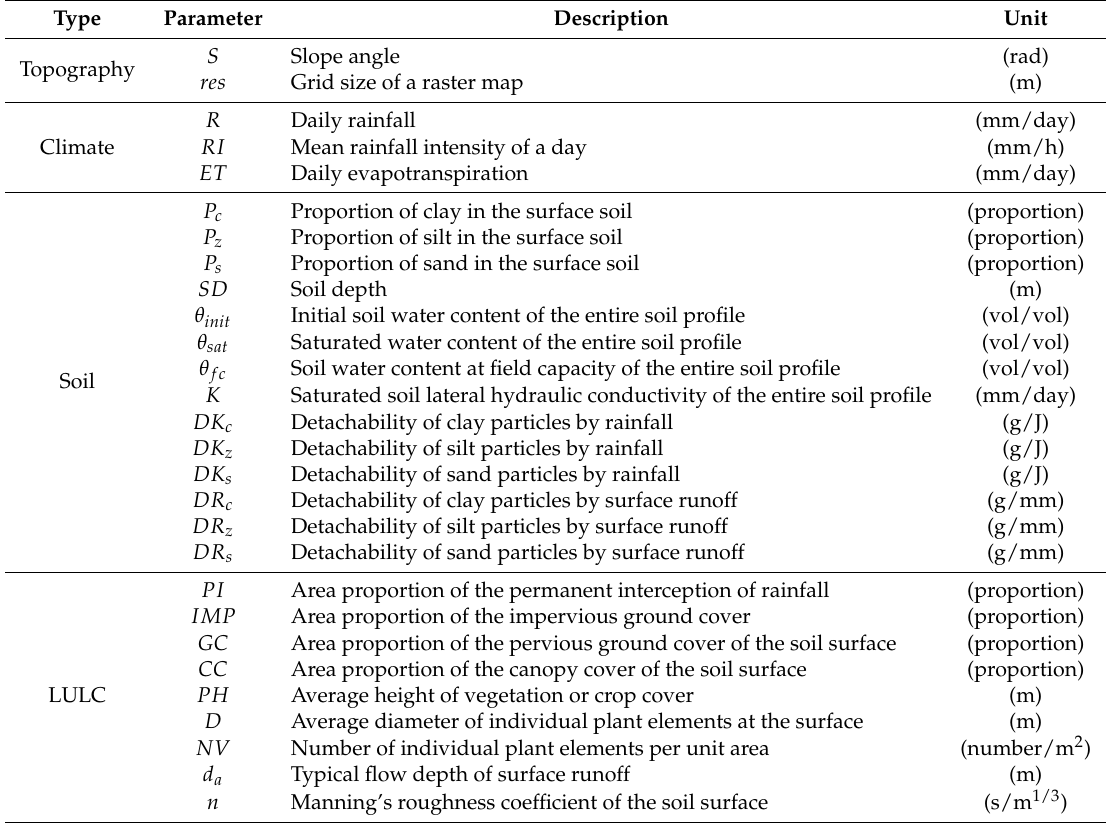
Table 1. Input parameters of the daily based Morgan–Morgan–Finney (DMMF) model (modified from Table 1 of Choi et al.